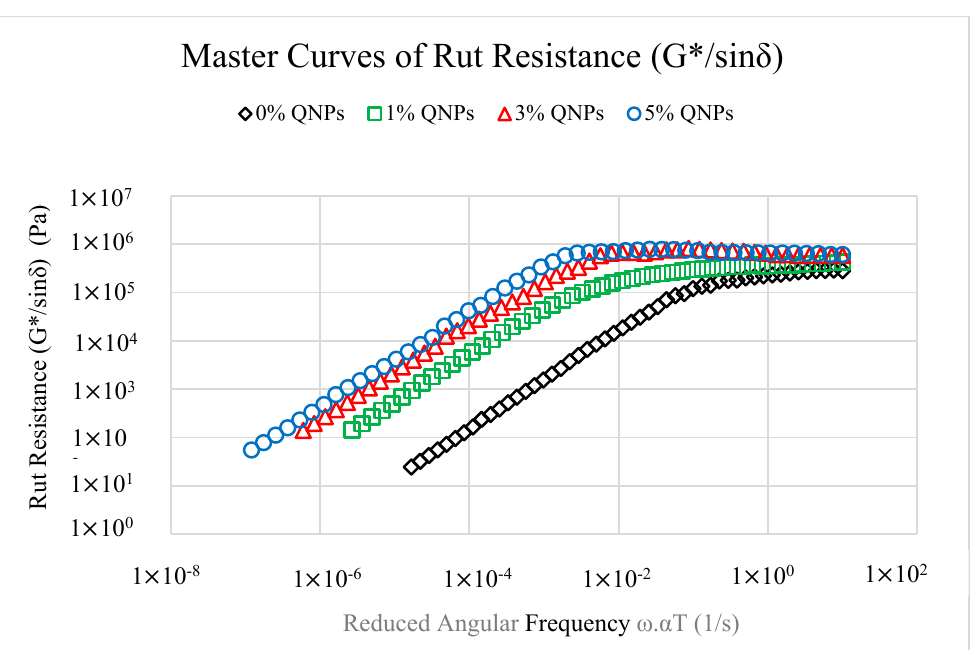
Figure 12. Master curves of G*/sin ( δ ) of all samples.